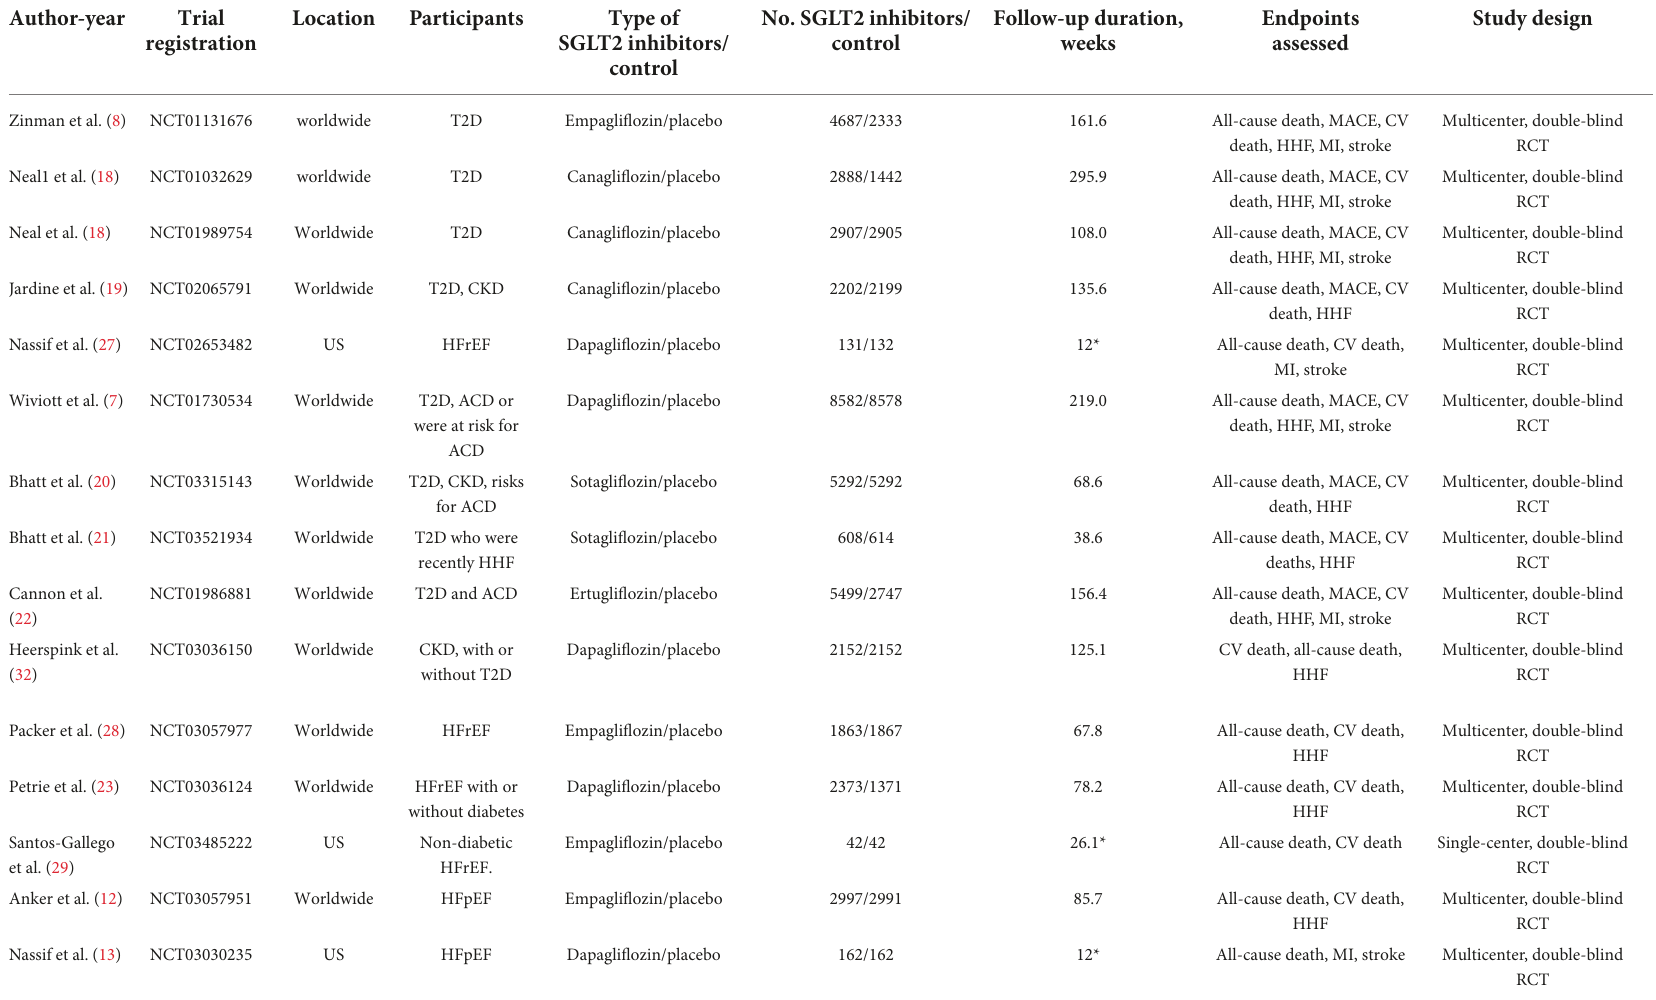
TABLE 1 Main characteristics of included